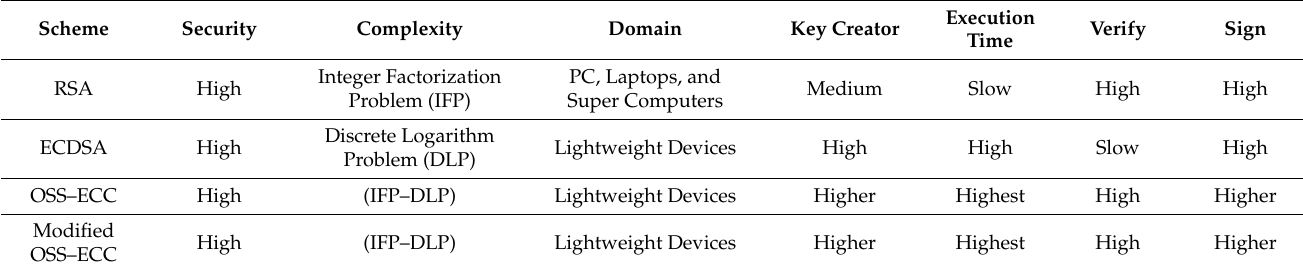
Table 3. Performance comparison between RSA, DSA, OSS–ECC, and proposed digital signature.